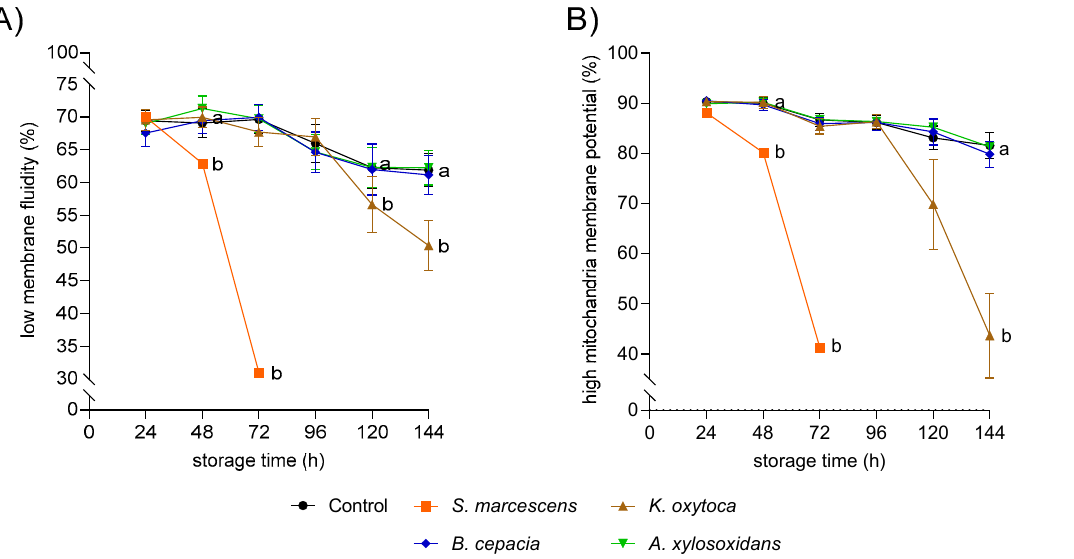
Figure 4. Viable sperm with low membrane fluidity ( A ) and viable sperm with high mitochondrial membrane potential ( B ) in extended semen spiked with four different multidrug-resistant bacterial species at ~10 3 CFU/mL. The samples extended in Beltsville Thawing Solution were stored at 17 °C for 144 h. Data are means and SEM ( S. marcescens : n = 7; other bacteria: n = 10). a, b: Different lowercase letters indicate differences between spiked samples and controls at a given storage time point ( p < 0.05).